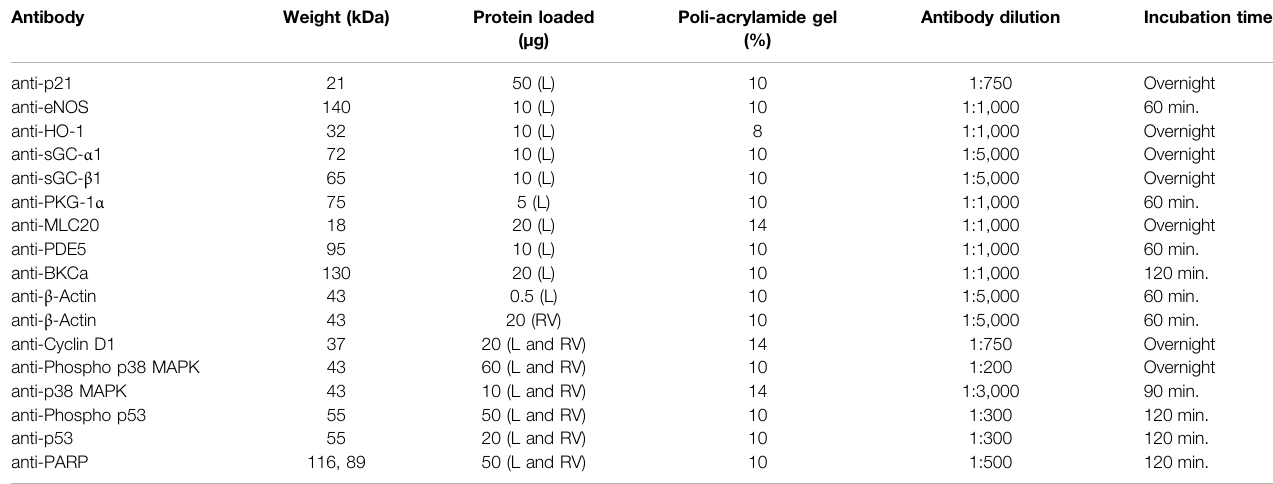
TABLE 1 | Westernblot conditions for each